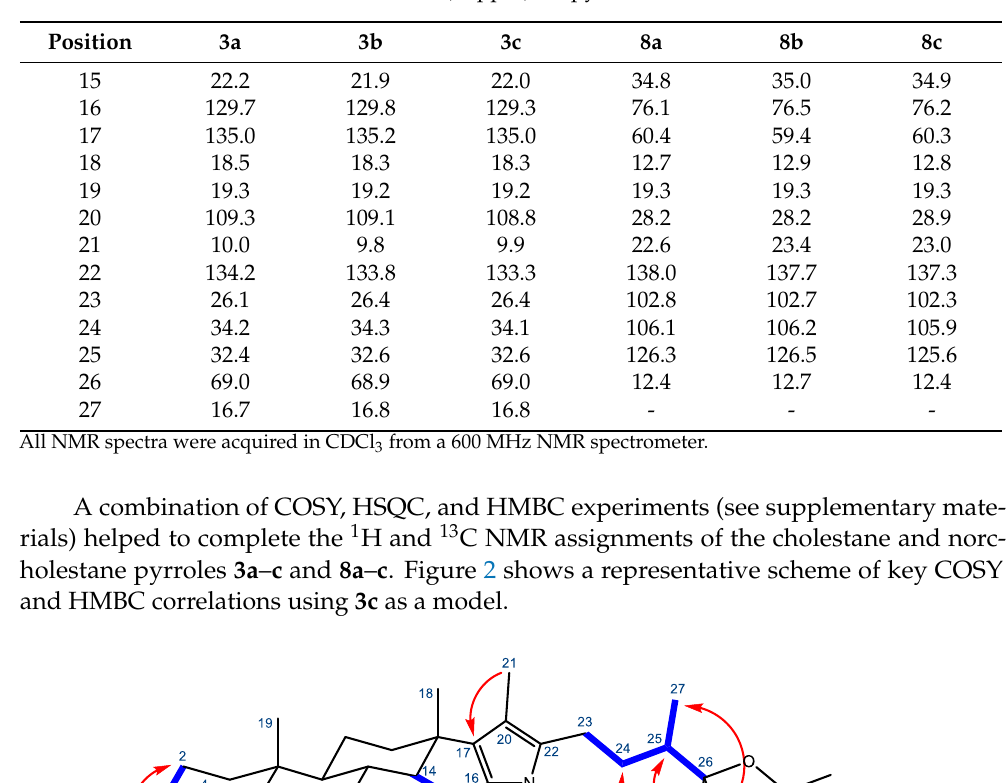
All NMR spectra were acquired in CDCl 3 from a 600 MHz NMR spectrometer. Table 3. Selected 13 C NMR chemical shifts (in ppm) for pyrroles 3a – c and 8a – c .